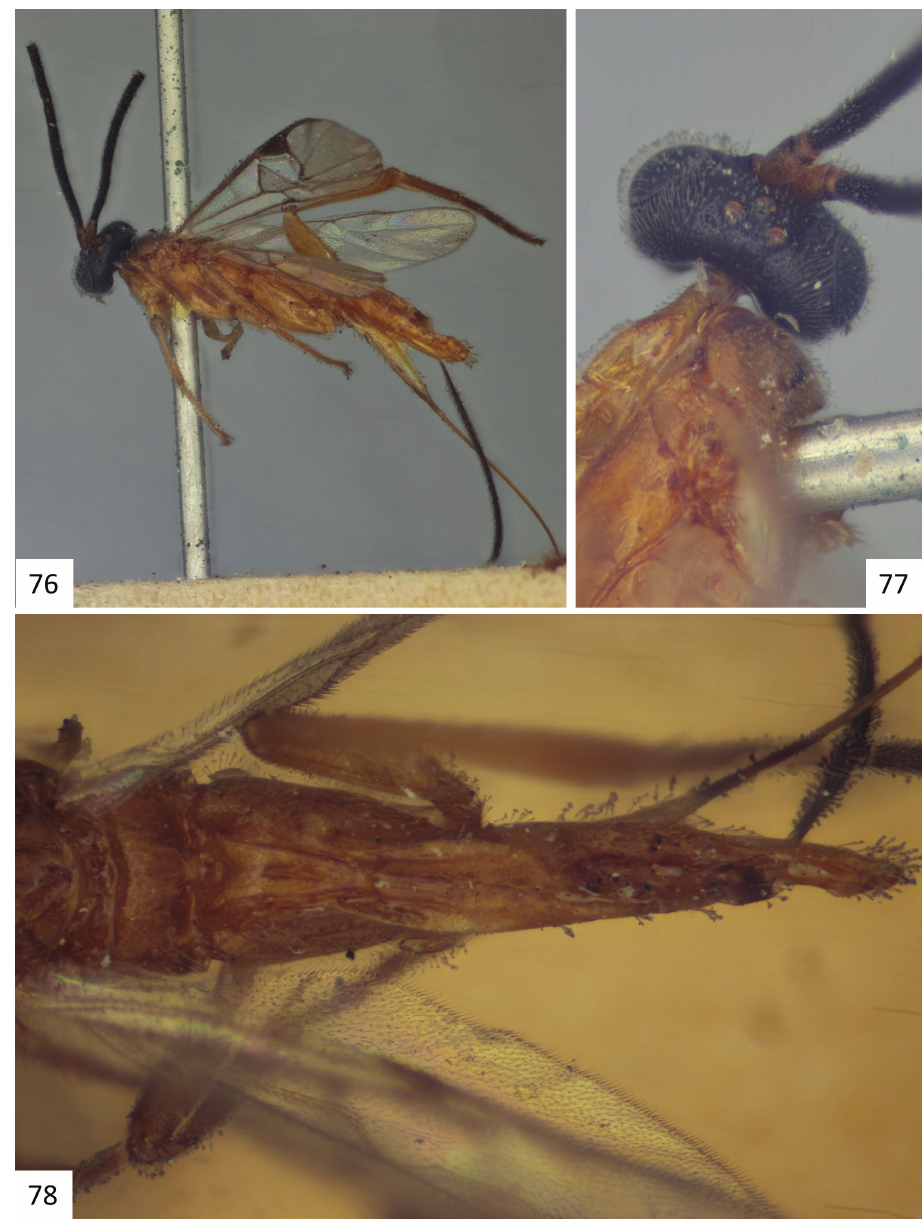
Figures 76–78. Sendaphne sulmo , female holotype. 76 Habitus, lateral view 77 Head and mesosoma (partially), dorsal view 78 Propodeum and metasoma, dorsal